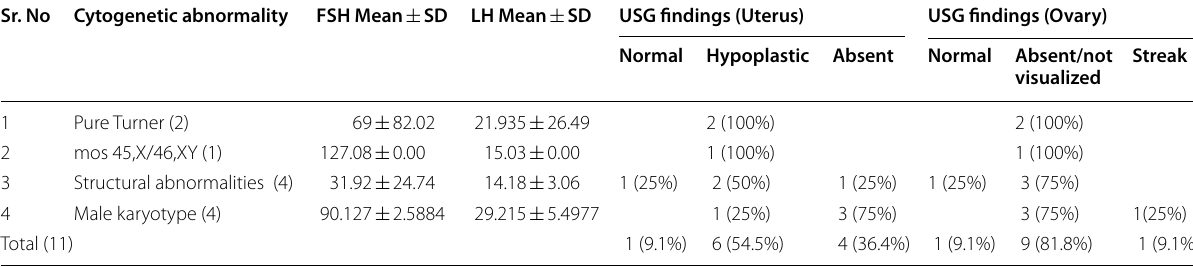
Table 4 Distribution of cytogenetic abnormality, FSH, LH levels and USG findings in PA Sr. No Cytogenetic abnormality